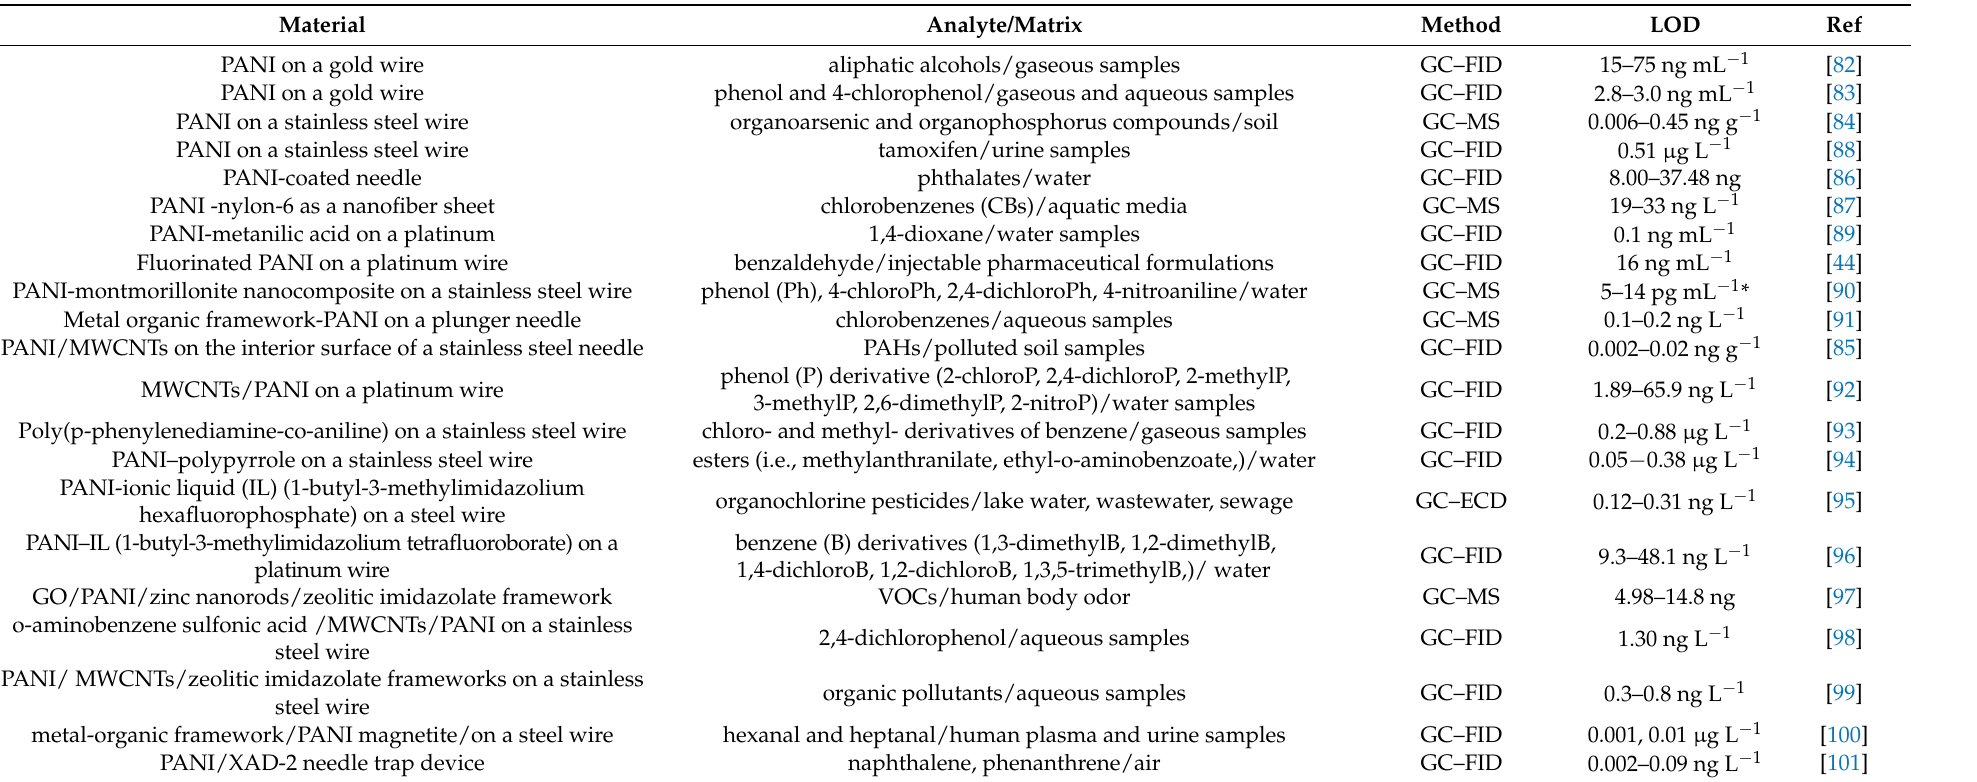
*—means that the value is limit of quantification